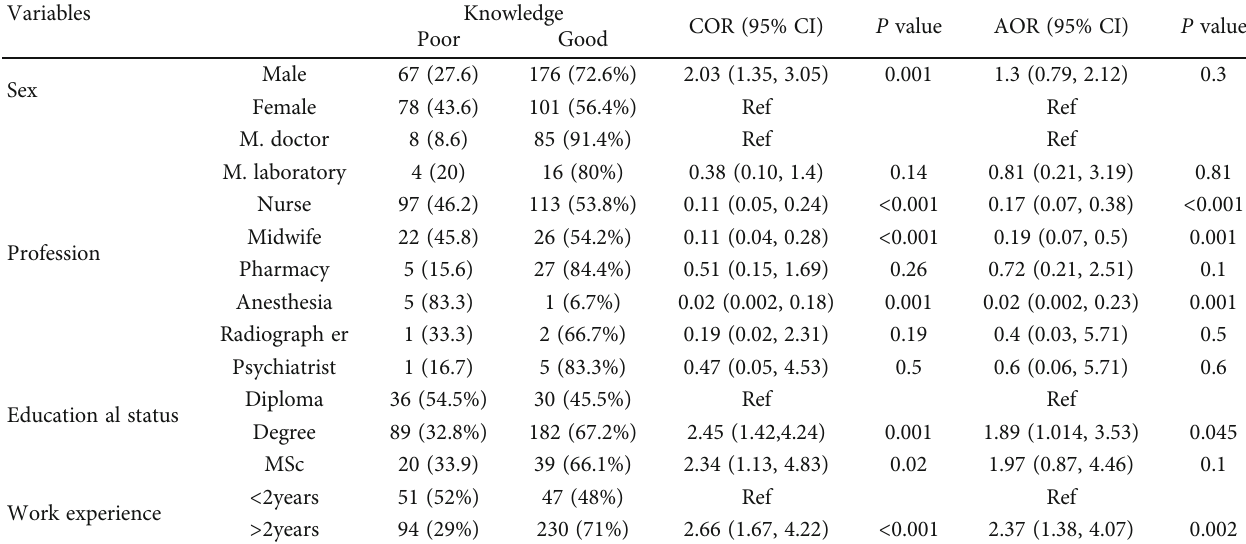
Table 8: Bivariate and multivariate analyses of factor associated with good knowledge towards HBV infections. Variables